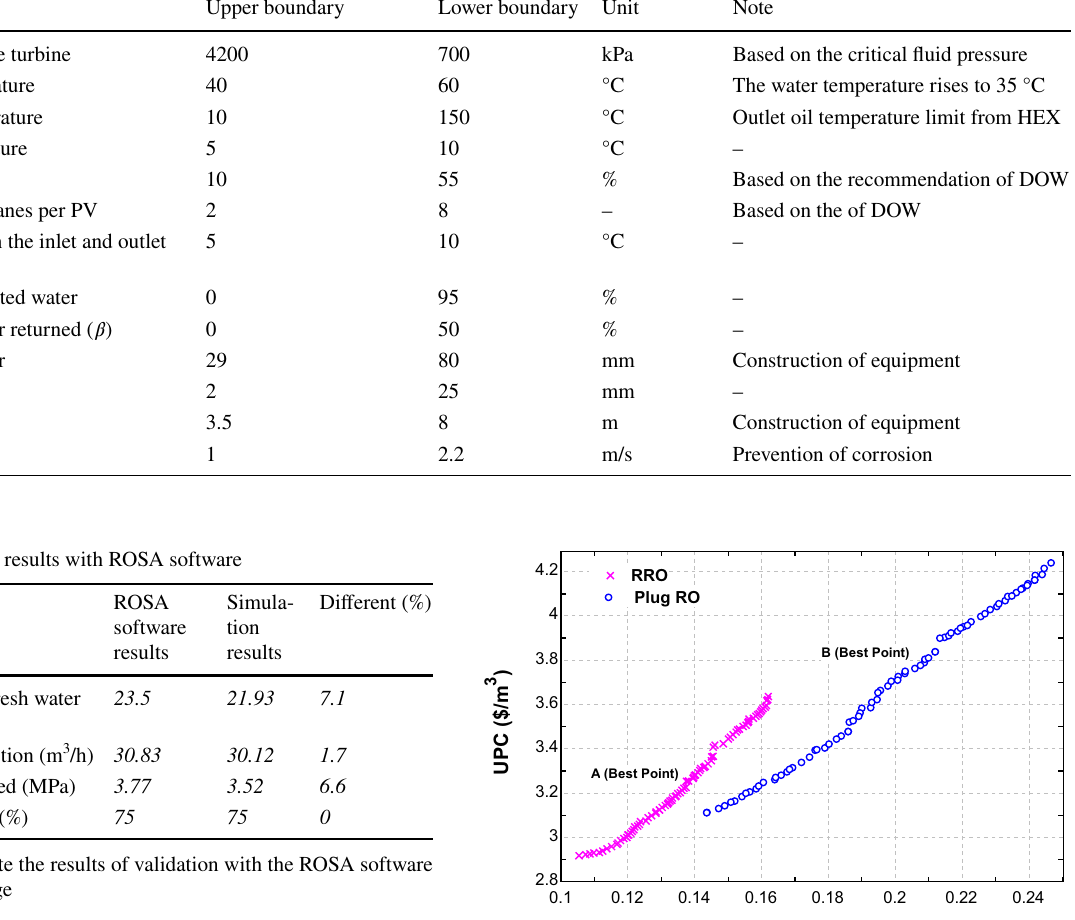
Italic values indicate the results of validation with the ROSA software and error